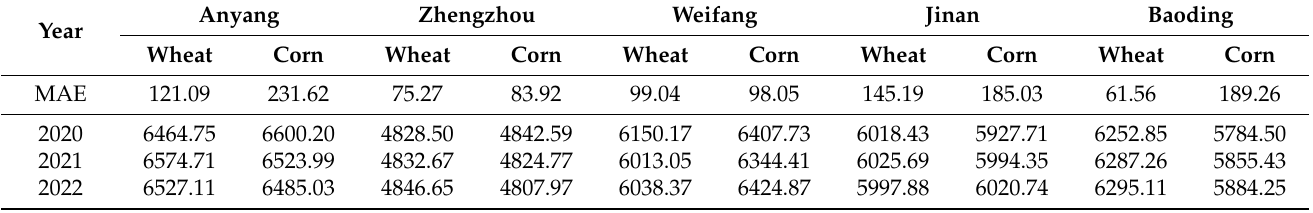
Table 9. Prediction accuracy and prediction results of yield per unit area (kg per hectare) in future.